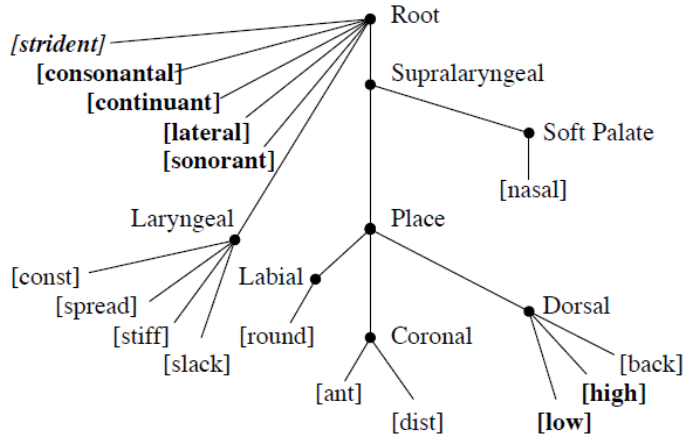
Figure 1. The feature geometry proposed by Sagey (1990, p. 205).